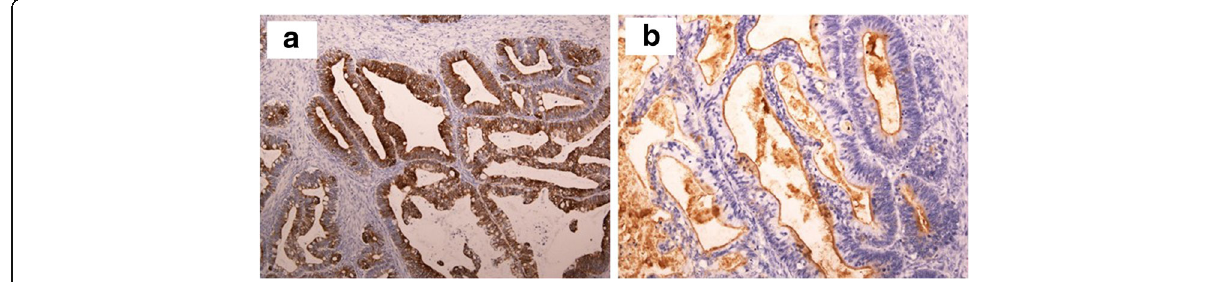
Fig. 4 An immuno-histopathological examination revealed positivity for CK 7 ( a ) and CEA ( b ) but negativity for CK 20 in the tumor